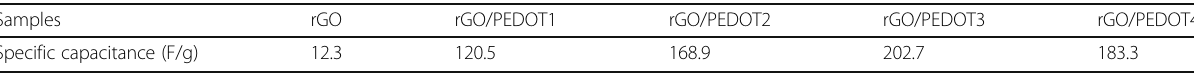
Table 2 Calculated specific capacitance of different electrodes